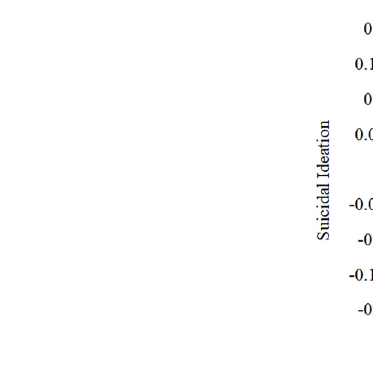
FIGURE 4 | The moderating effect of interdependent self-construal on the relation between army morale and suicide ideation. Variables in the models are standardized. Army morale and interdependent self-construal are graphed for two levels: 1 standard deviation above the mean is high level, and 1 standard deviation below the mean is low level. *** p <